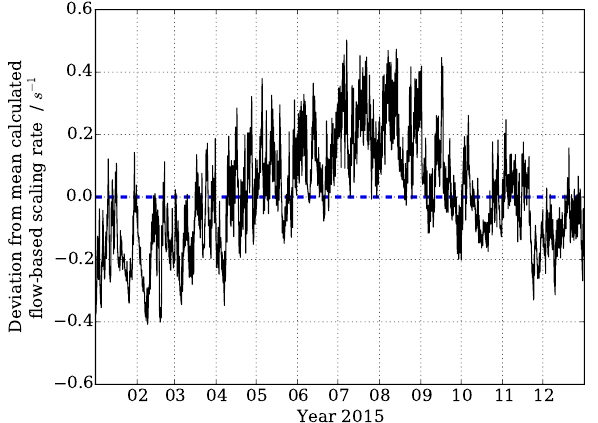
Figure 5. Variability around mean flowspeed-based calculated scal- ing rate dependent on 10min observed pressure and temperature measurements at MOHp in